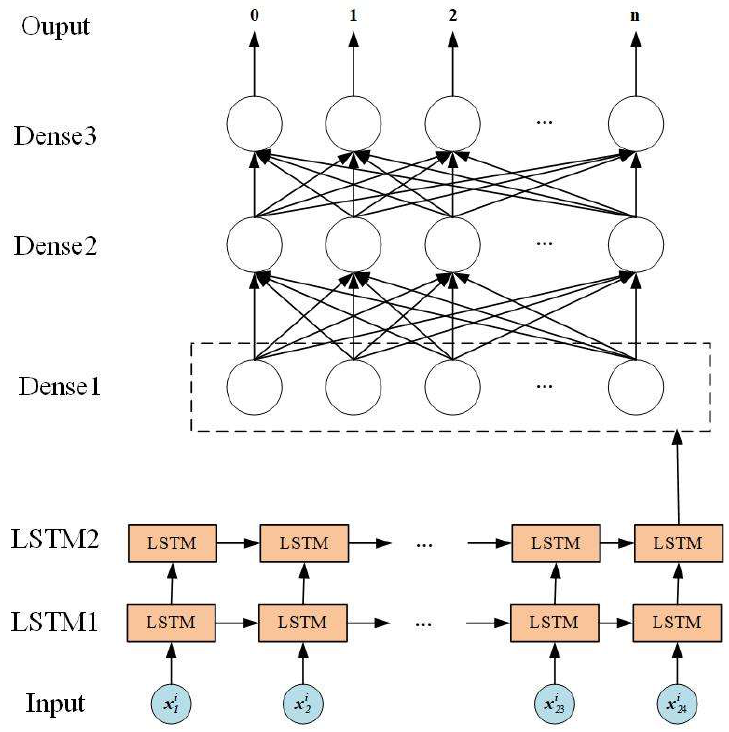
Figure 4. The LSTM neural network model.